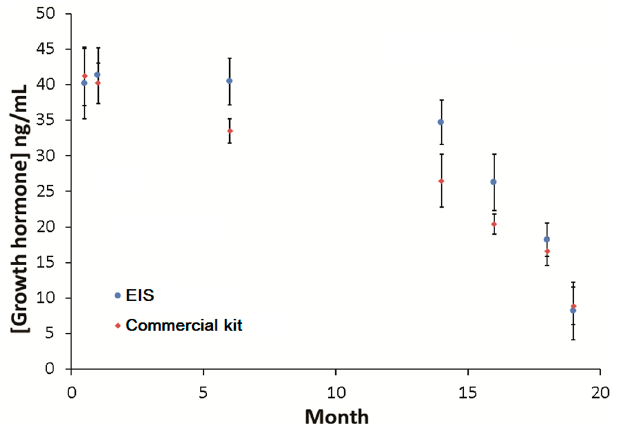
Figure 5. Dependence of growth hormone concentration on the age of rats. The results of EIS-based immunosensor using screen-printed carbon electrodes (SPCE) was compared with those obtained using the commercial detection kit as described in the Section 2.7. Error bars indicate the standard deviation of three consecutive measurements (n = 3) performed using the samples collected on the same day of each month. Table 1. A summary of published literature on the detection of GH using biosensors with optical and electrochemical detection techniques.